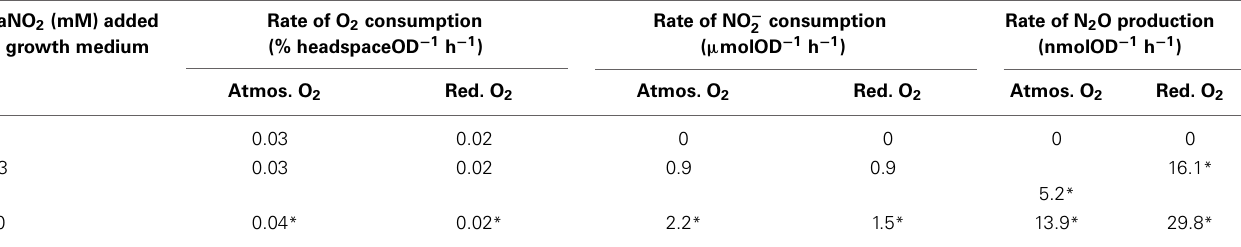
Values represent slopes of averaged measurements from 5 experiments initiated on different cultures and on different days (y-axis) over time (48–72 h; x-axis).